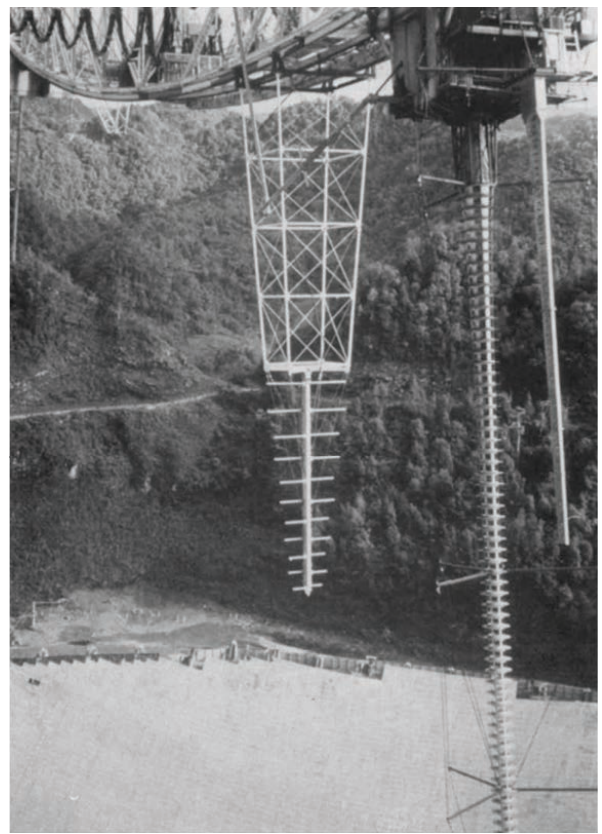
Figure 8. The Max Planck Institute for Aeronomy 46.8MHz SOUSY radar feed mounted downhill from carriage house 1 (CH1) and towed by CH1. This was an 11-element log-periodic an- tenna with 45–55MHz frequency range and an 8dB gain, yielding 60 ◦ half-power beamwidth to e ffi ciently illuminate the dish. The 430MHz radar line feed and 318MHz radio astronomy feed are mounted on the carriage house (R¨ottger et al.,